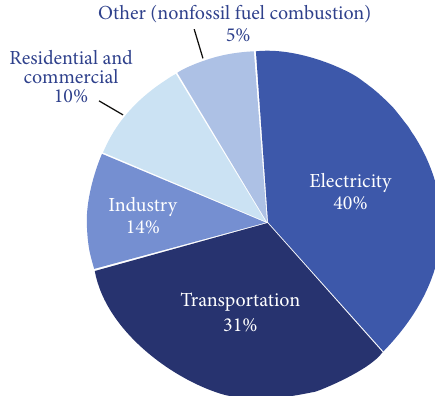
Figure 1: Sources of CO 2 emissions by sector (worldwide,